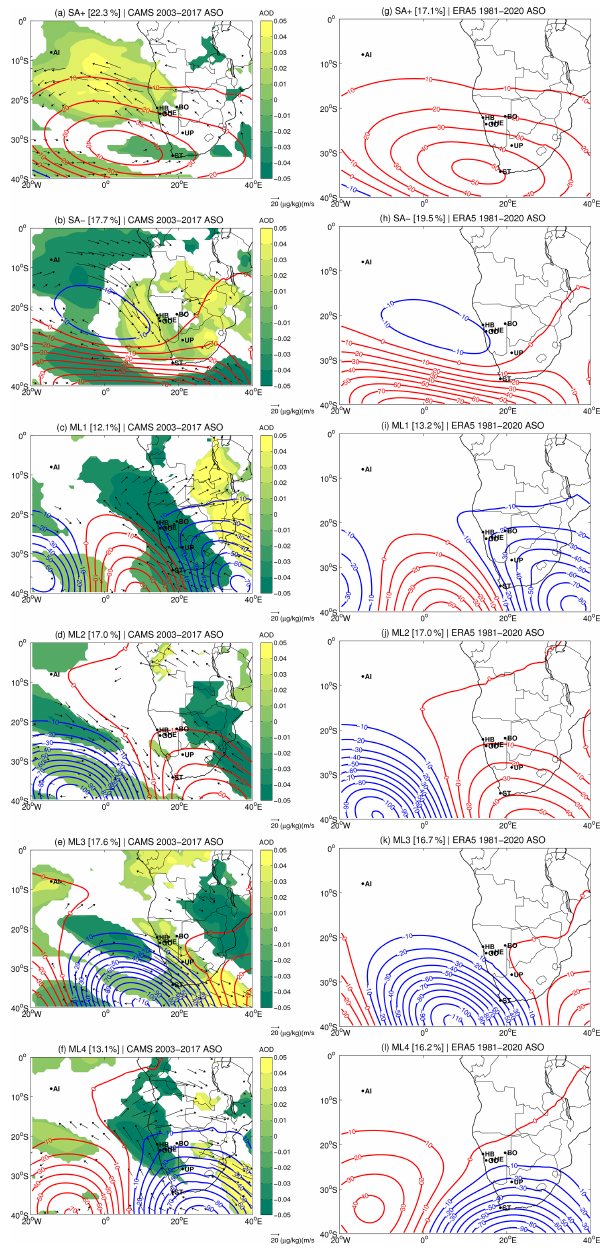
Figure 4. Left panels: anomaly patterns of CAMS geopotential height (m, contours), AOD at 550nm (shading) and organic matter transport ((µgkg − 1 ) (ms − 1 ), arrows) at 700hPa associated with the WRs classified from CAMS geopotential height at 700hPa in ASO 2003–2017. Right panels: anomaly patterns of ERA5 geopotential height (m, contours) at 700hPa associated with the WRs classi- fied from ERA5 geopotential height at 700hPa in ASO 1981–2020. Dots indicate the locations of the AERONET stations used in this study. Frequency of the WRs is indicated in brackets. For AOD and organic matter transport, only values significant at the 95% level of confidence after a Student’s t test are displayed.